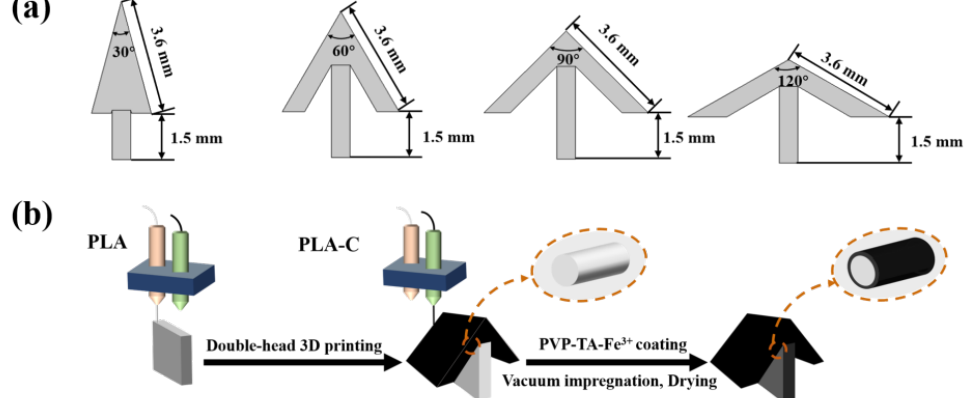
Figure 2. ( a ) numerical design of angle between photothermal layer of the crystallizer; ( b ) schematic diagram of crystallizer preparation process.